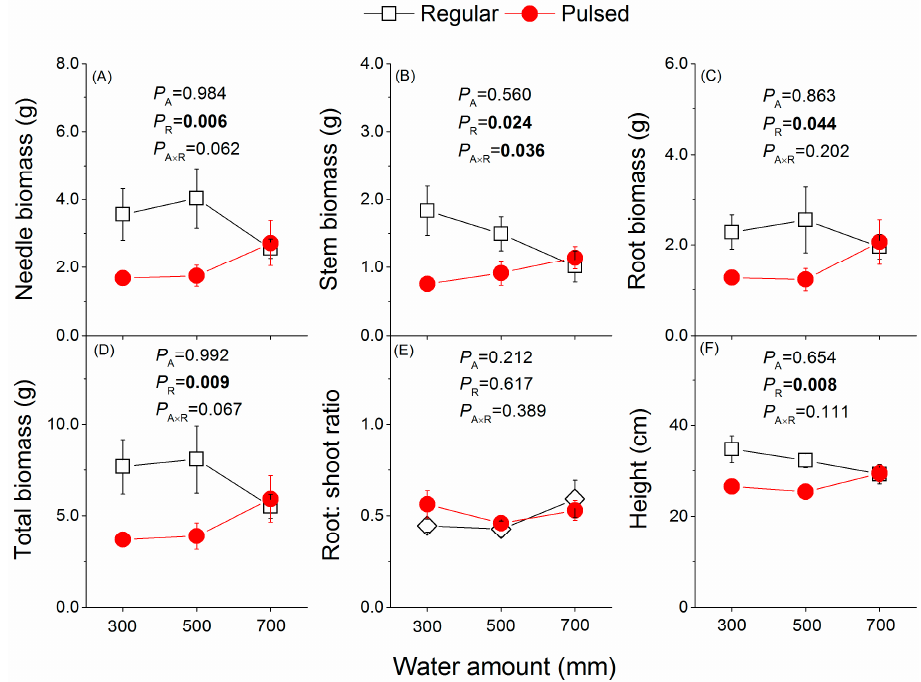
Figure 3. Effects of the watering regime (regular vs. pulsed) and water amount (300, 500, and 700 mm) on needle biomass ( A ), stem biomass ( B ), root biomass ( C ), total biomass ( D ), root to shoot ratio ( E ) and height ( F ) of P. massoniana saplings. p values of two-way ANOVAS are given. A and R represent water amount and watering regime, respectively. Plotted are means ± SE.